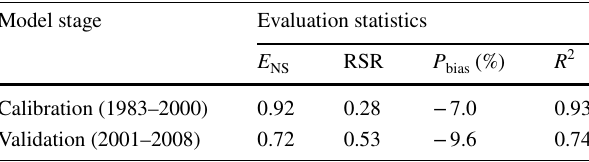
Fig. 15 Correlation between monthly observed and simulated. Stream flow measured during validation (2001–2008) Table 6 Evaluation of SWAT model performance on monthly time basis